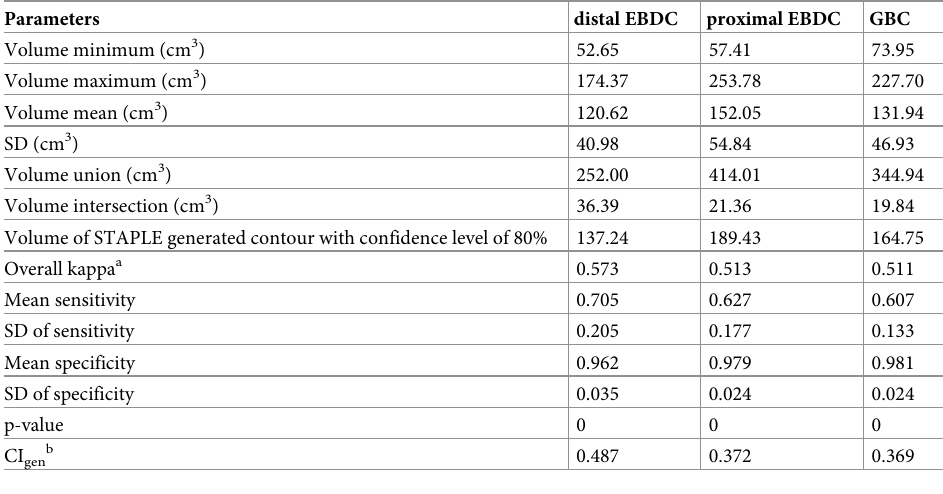
Table 2. Summary of clinical target volume (CTV)